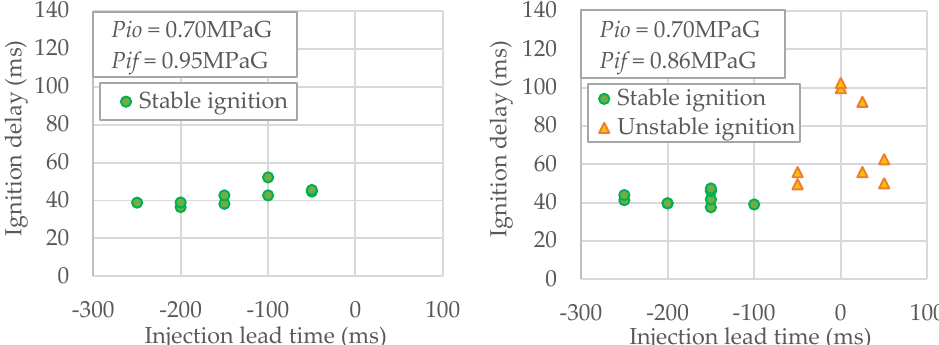
Figure 13. Measured ignition delay in each injection lead time condition (fuel ‐ lead time: negative, oxidizer ‐ lead time: positive).